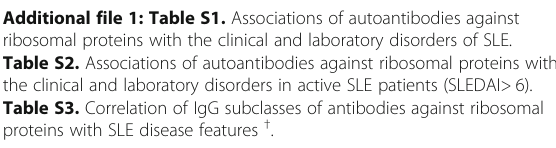
Table S3. Correlation of IgG subclasses of antibodies against ribosomal proteins with SLE disease features † . Acknowledgements Not